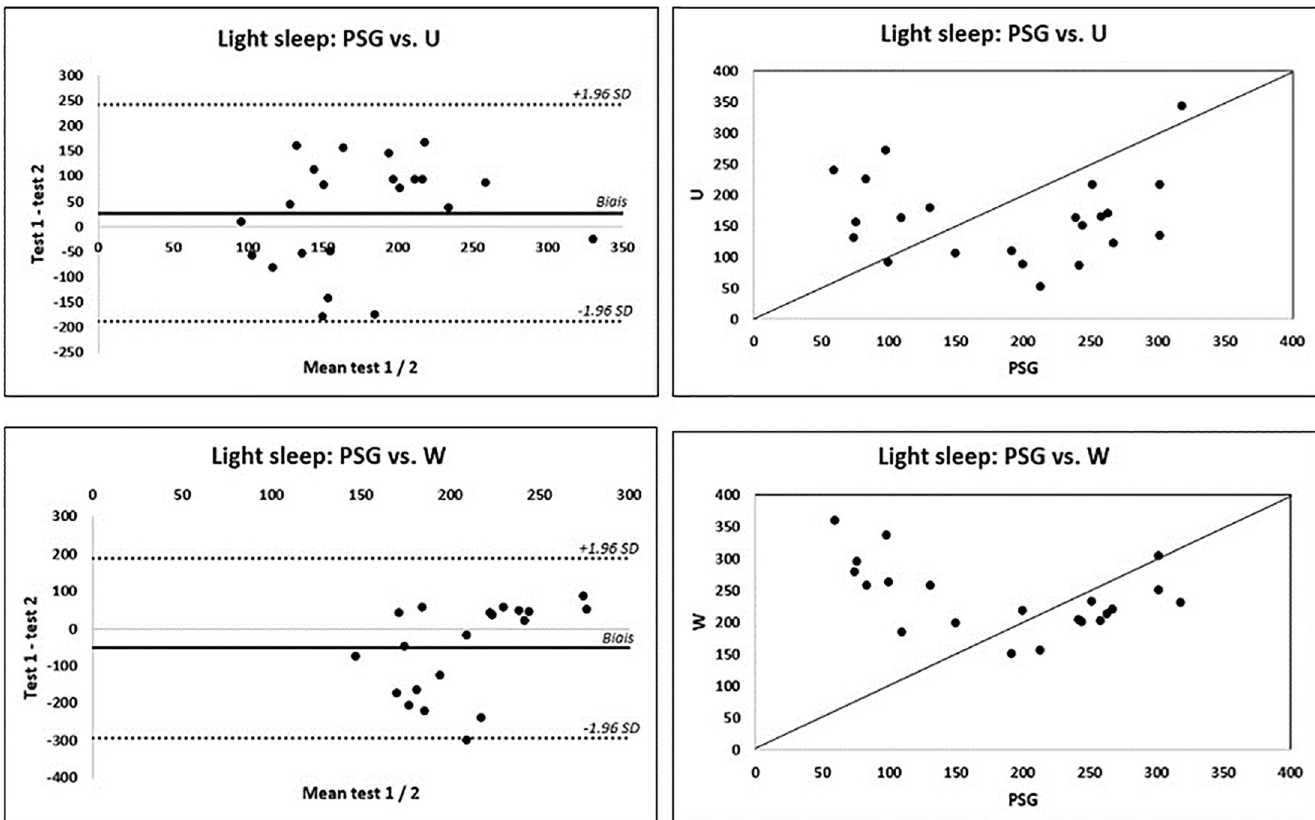
Fig 2. Reliability for light sleep parameter. Fig 2A. (left) represents Bland-Altman plots of differences between measurements of light sleep as measured by PSG (polysomnography), expressed in minutes, and by the activity monitors (U shows an underestimation of 27 min, in contrast to W, which shows an overestimation of 52 min). W: Withings pulse 02, U: Up Move Jawbone. Fig 2B. (right) shows the agreement between PSG and activity monitors (U and W) for the light sleep parameter. A systematic effect is observed because values are not uniformly distributed around the identity line (line with a 45˚ slope).